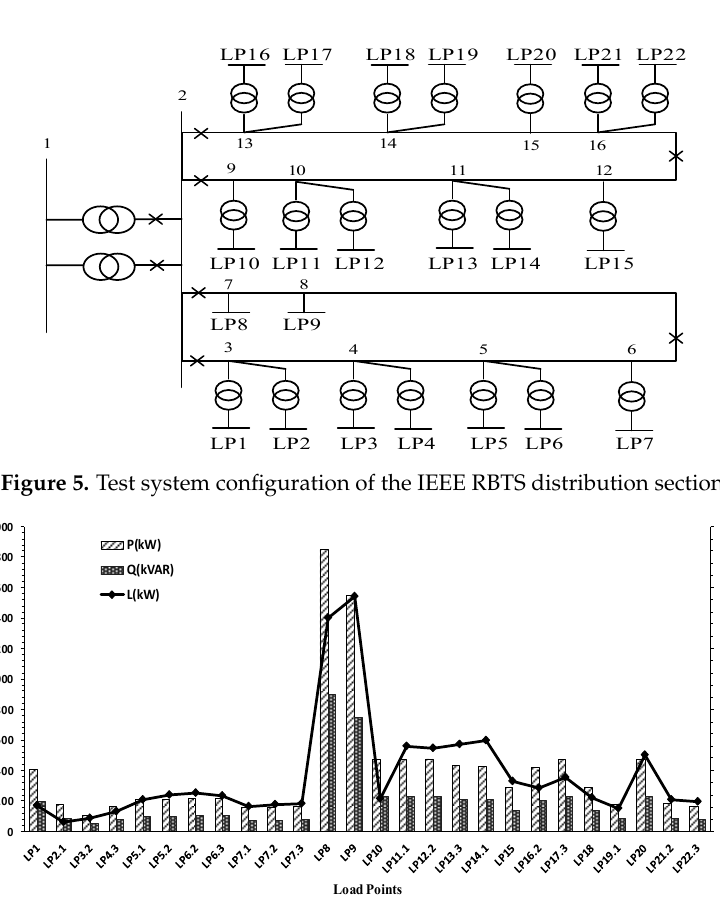
Figure 6. Allocated losses for the scenario when DGs are ignored.